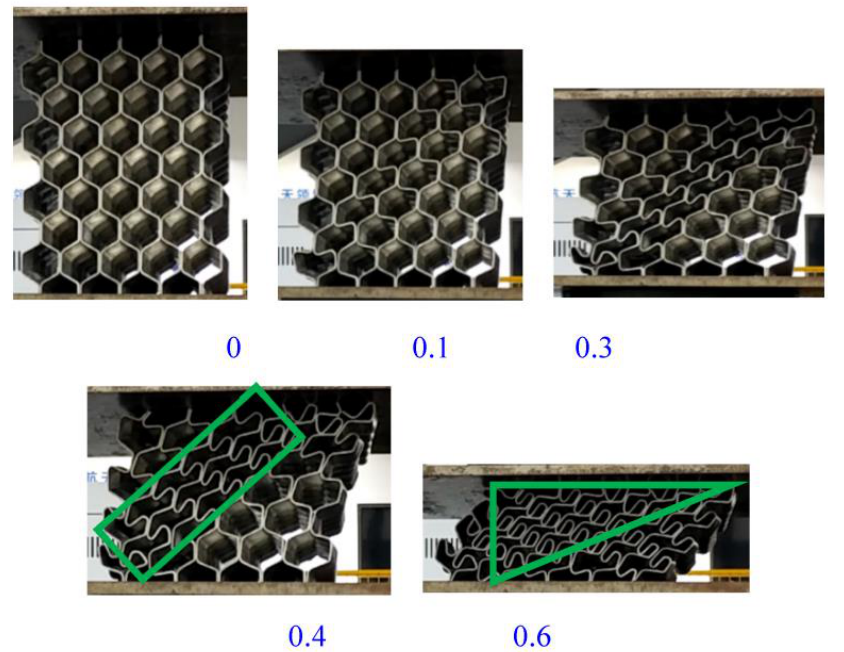
Figure 5. Pictures of the radial compression process of origami honeycomb 2.